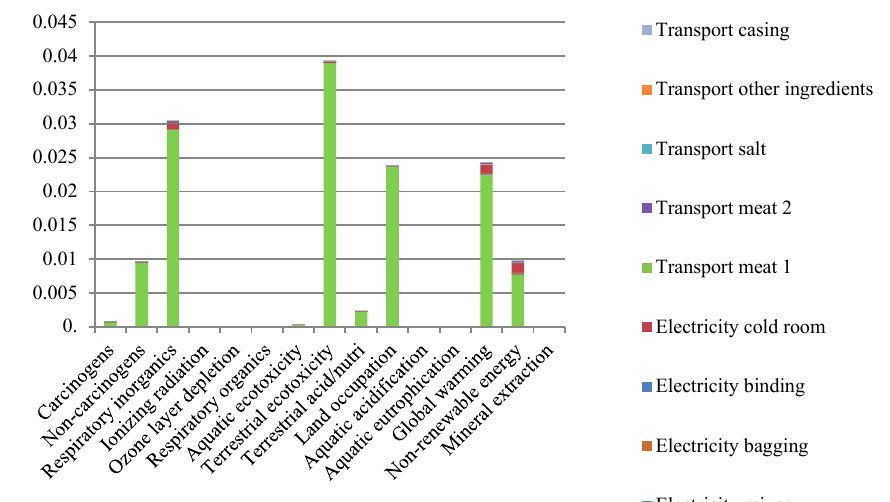
Fig. 4. Normalization impact assessment of fresh sausage – whole agri-food chain (values in normalized